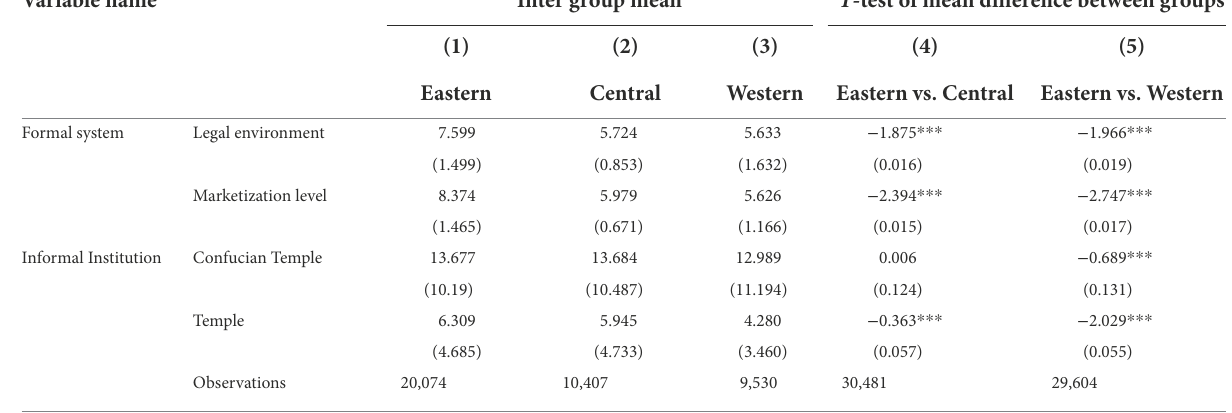
TABLE 6 Regional differences in the institutional environment.